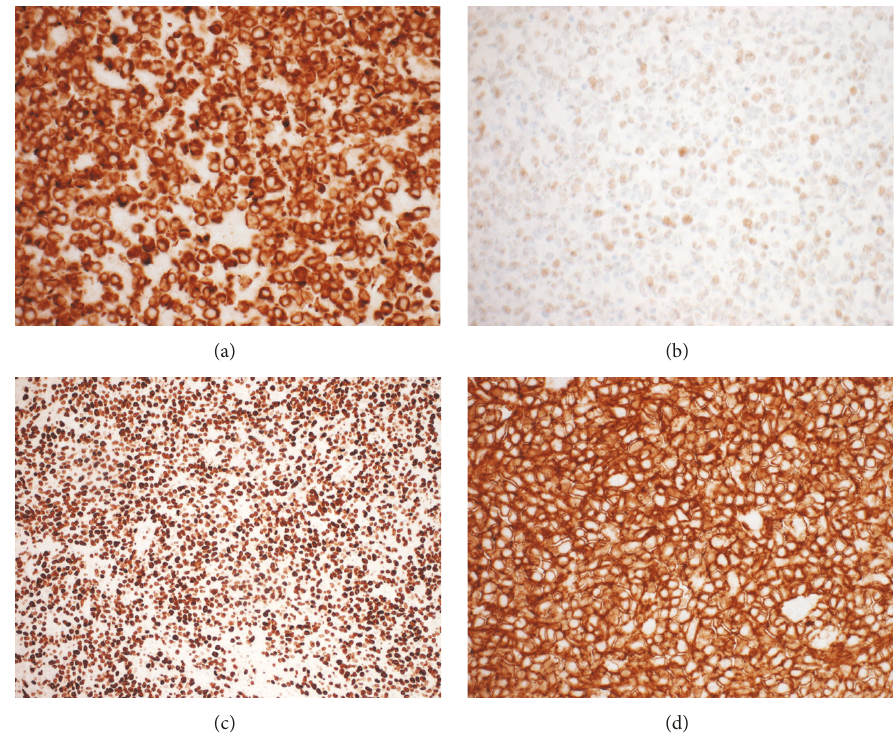
Figure 3: Histopathological findings of the monomorphic posttransplant lymphoproliferative disorder; diffuse large B-cell lymphoma of the right testis. Immunophenotyping, via immunohistochemistry, revealed neoplastic cells positive for Bcl-2 (a), Bcl-6 (b), Ki-67 (proliferation index > 90%) (c), and CD20 (d). Magnification for all panels: